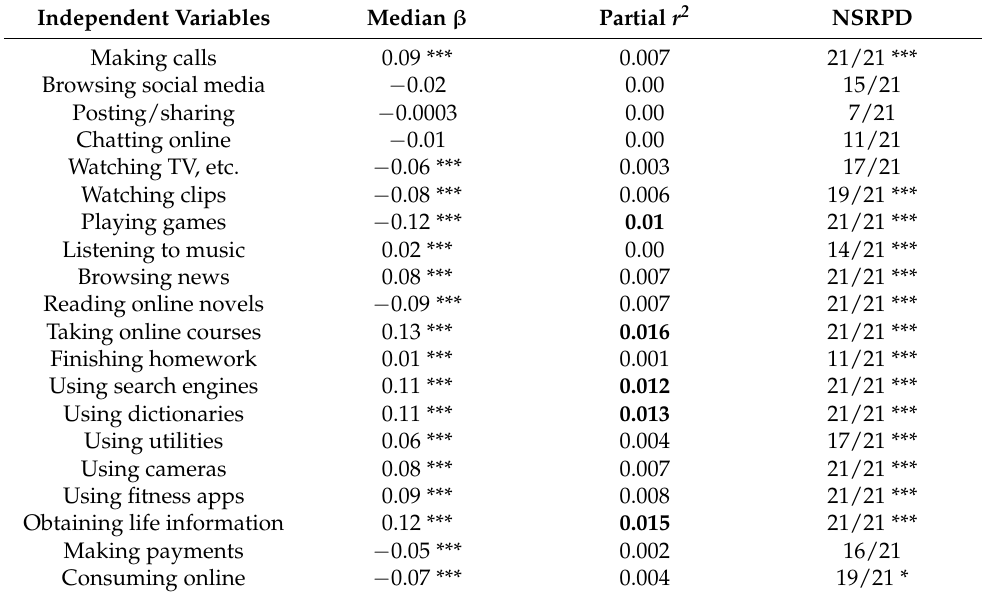
Table 2. The results of SCA for the different types of smartphone use content and social